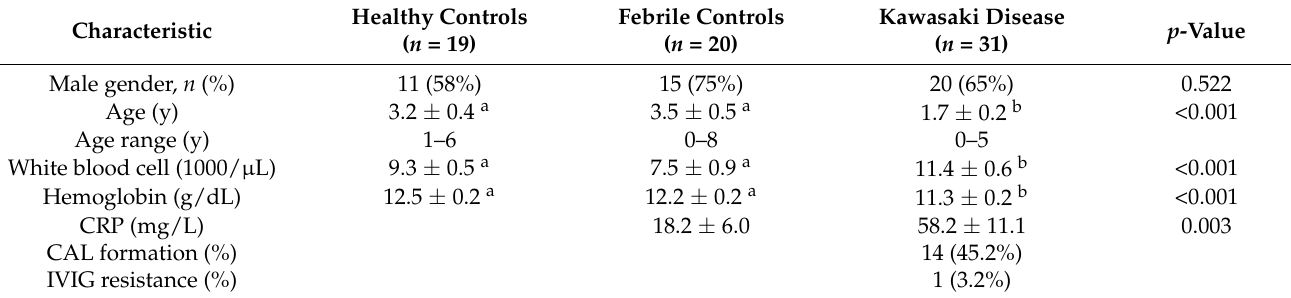
Table 1. Basal characteristics of patients with KD and